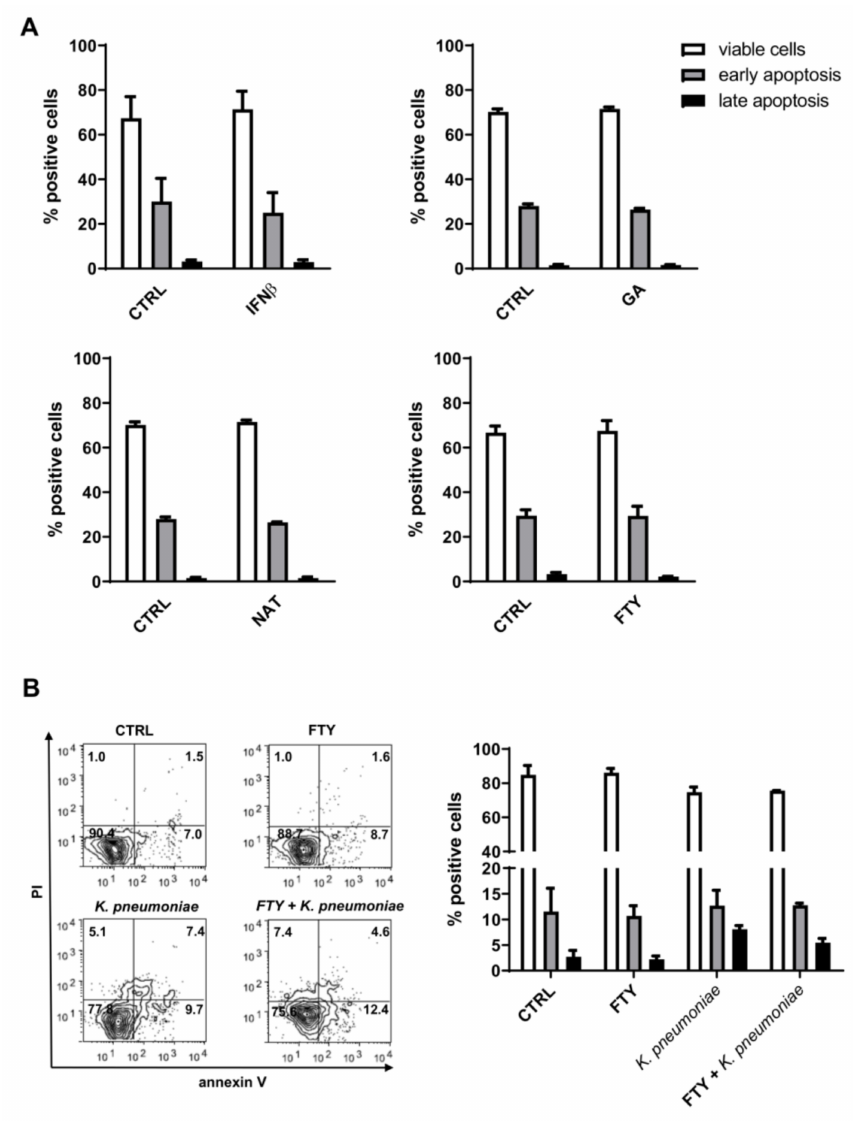
Figure 2. DMT treatment does not promote PMN apoptosis. Cell apoptosis was measured by annexin V-fluorescein isothiocyanate (FITC) and propidium iodide (PI) staining. ( A ) Human neutrophils were treated with the indicated DMT (IFN β -1b, GA, NAT or FTY) for 3 h and then analyzed by flow cytometry. ( B ) Cells were pretreated with or without FTY for 1 h and then incubated with or without K. pneumoniae (10:1) for 2 h. Representative flow cytometry dot plots with double Annexin V-FITC / PI staining are shown in the bottom left panel. Quantitative analysis of viable neutrophils, cells in early apoptosis (annexin V positive) or in late apoptosis (annexin V positive / PI positive) are shown. Data are expressed as mean ± SEM from three independent experiments and analyzed using the Mann–Whitney test for nonparametric